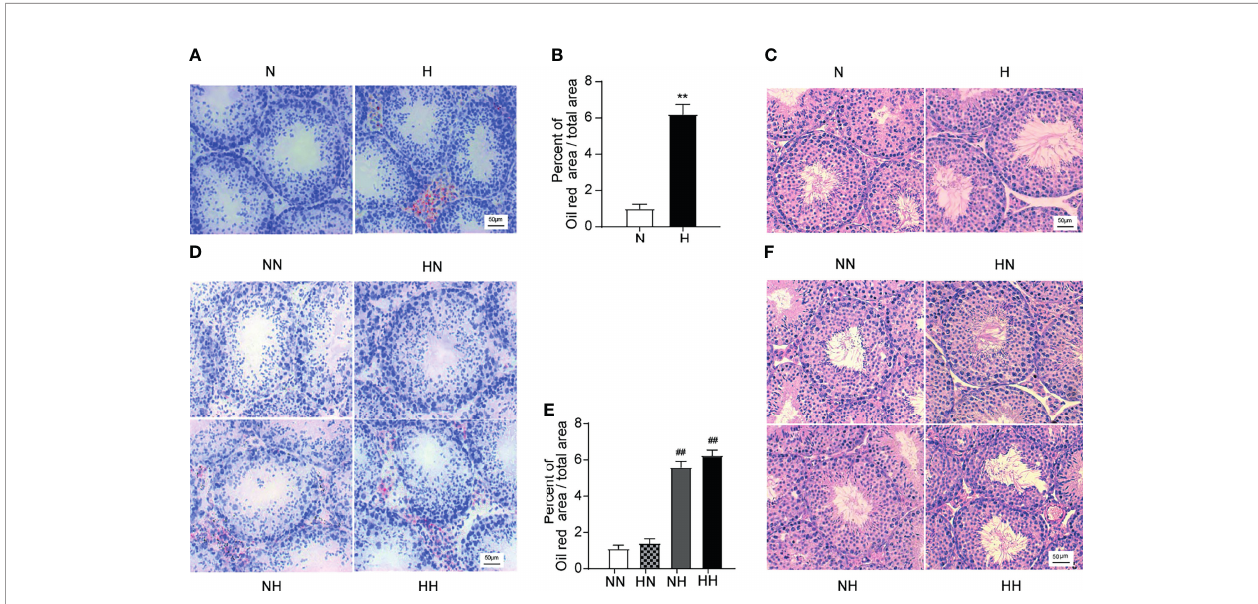
FIGURE 5 | Testicular lipid deposition and morphological induced by high-fat diet during sexual development (A) Oil red O stained testicular sections at the 8th -week age of mice, and lipid abundance in the testis was analysed (B) (n=3 for each group). (C) Oil red O stained testicular sections at the 16-week age of mice, and lipid abundance in the testis was analysed among NN group, HN group, NH group, HH group (D) (n=3 for each group). (E) Representative photomicrographs of H&E staining of testicular sections at 8th week were shown, H&E stained testicular sections at the 16th week of feeding were observed among NN group, HN group, NH group, HH group (F) (n=3 for each group). All of the above micrographs were from at least three independent experiments, magni fi cation were 200 times. Results are presented as mean ± SEM. **p < 0.01 vs the N group. ## p < 0.01 vs the NN group.